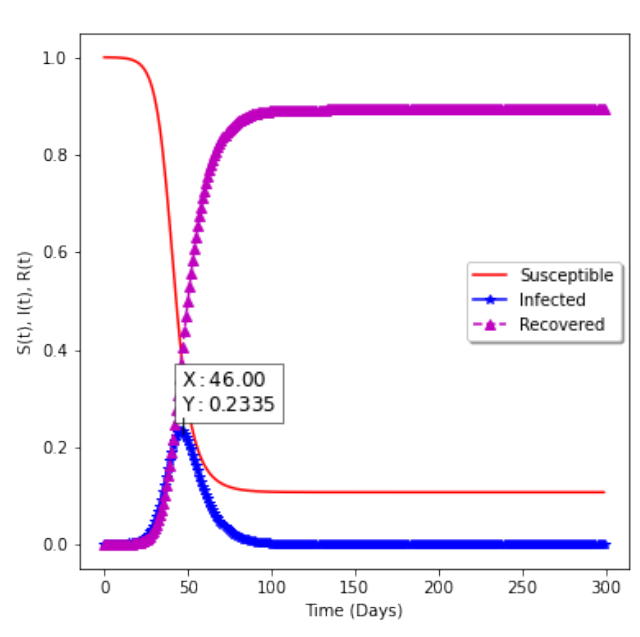
Figure 8. Model without vaccination.